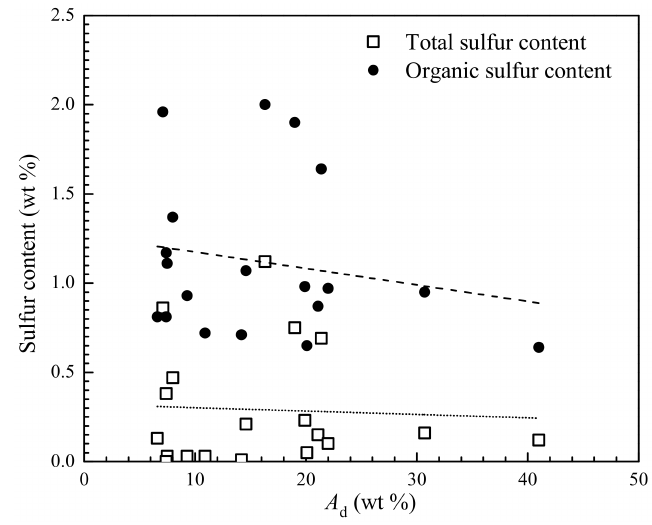
Figure 10. Comparison of isotopic composition of organic and pyritic sulfur.